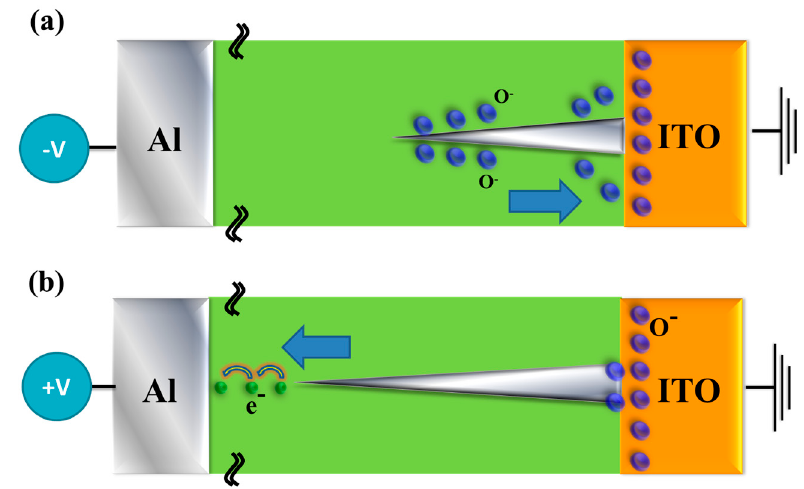
Figure 7. Electrical transferred mechanisms and initial metallic filament path diagram of the thin films resistive random access memory (RRAM) devices for ( a ) reset, and ( b ) set process.